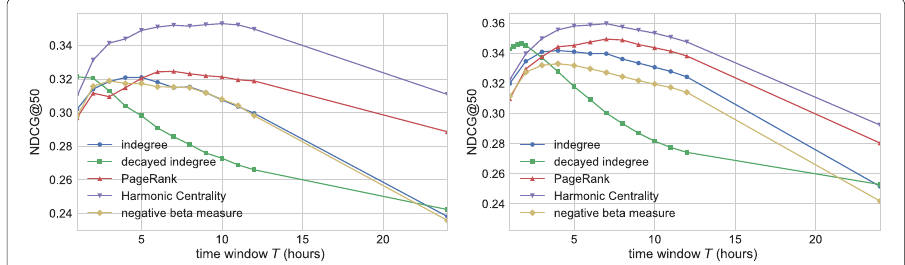
Fig. 11 NDCG@50 performance of the baseline methods as the function of time window T . For online baseline exponential degree results are shown as the function of half-life τ . Left: UO17, Right: